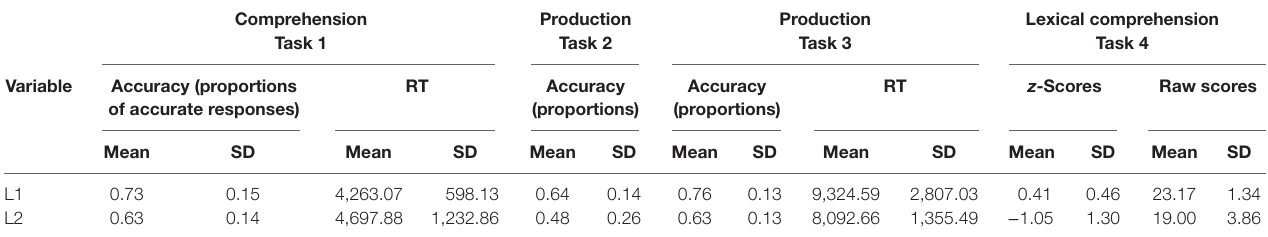
TaBle 4 | Descriptive statistics (mean and SDs) of all variables for the morphological awareness tasks and for the lexical comprehension task in L2 children and in L1 peers matched for chronological